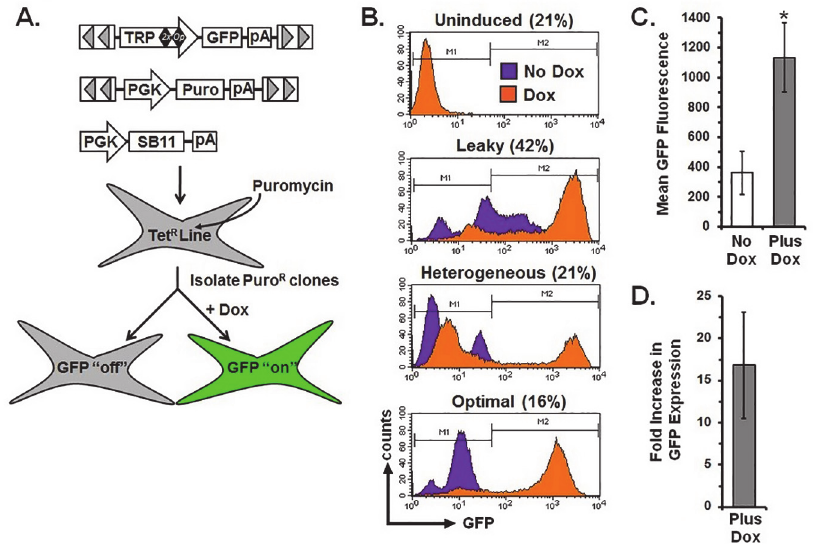
Table 2. Phenotypes of cell lines generated using a commercially available Tet-On vector system and Sleeping Beauty transposon-mediated integration.